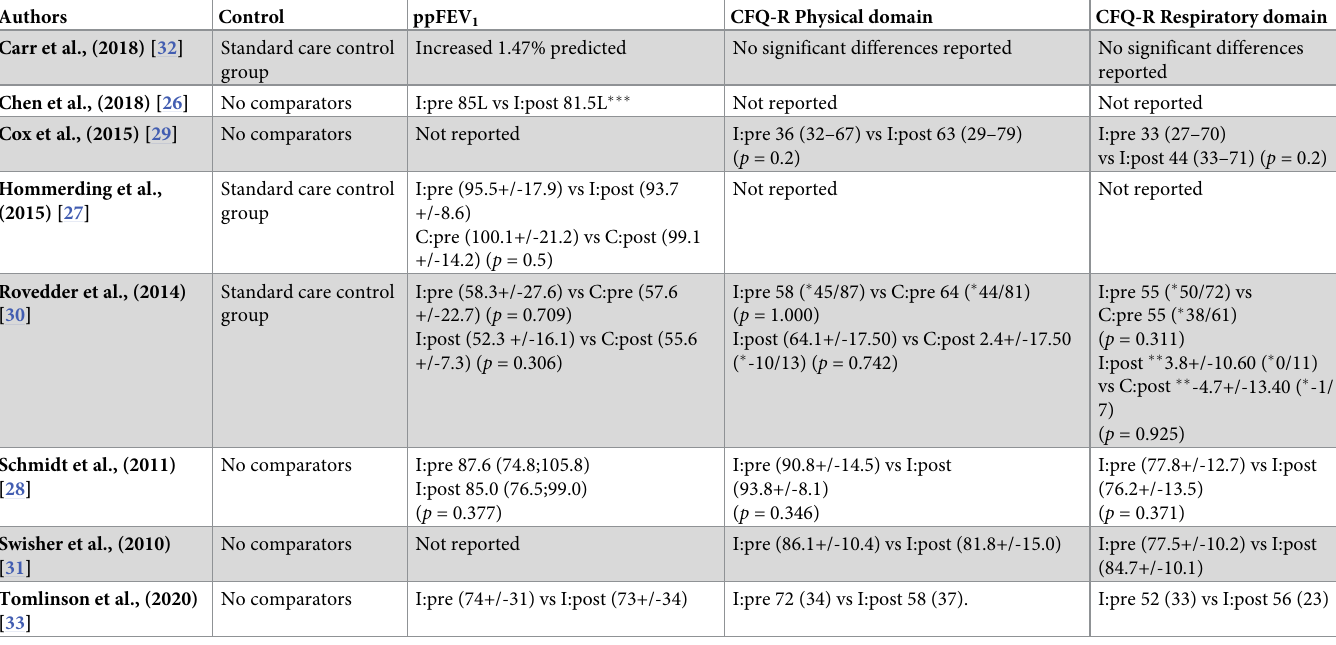
Table 5. Key findings of the outcome measures in the eight included